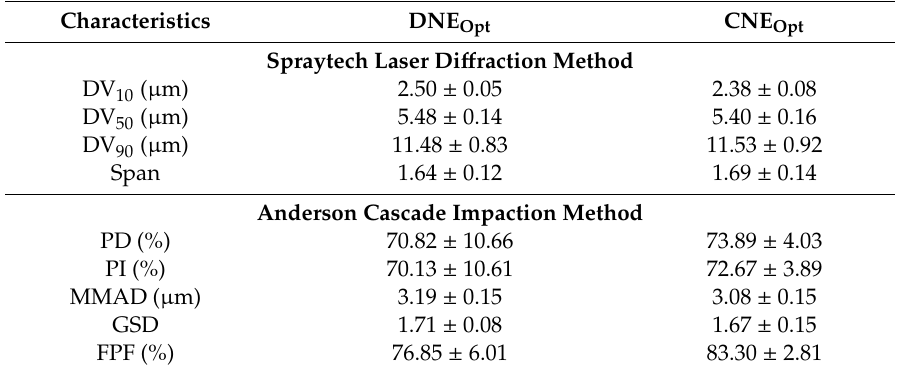
Table 5. Aerosolization and inhalation performances of optimized